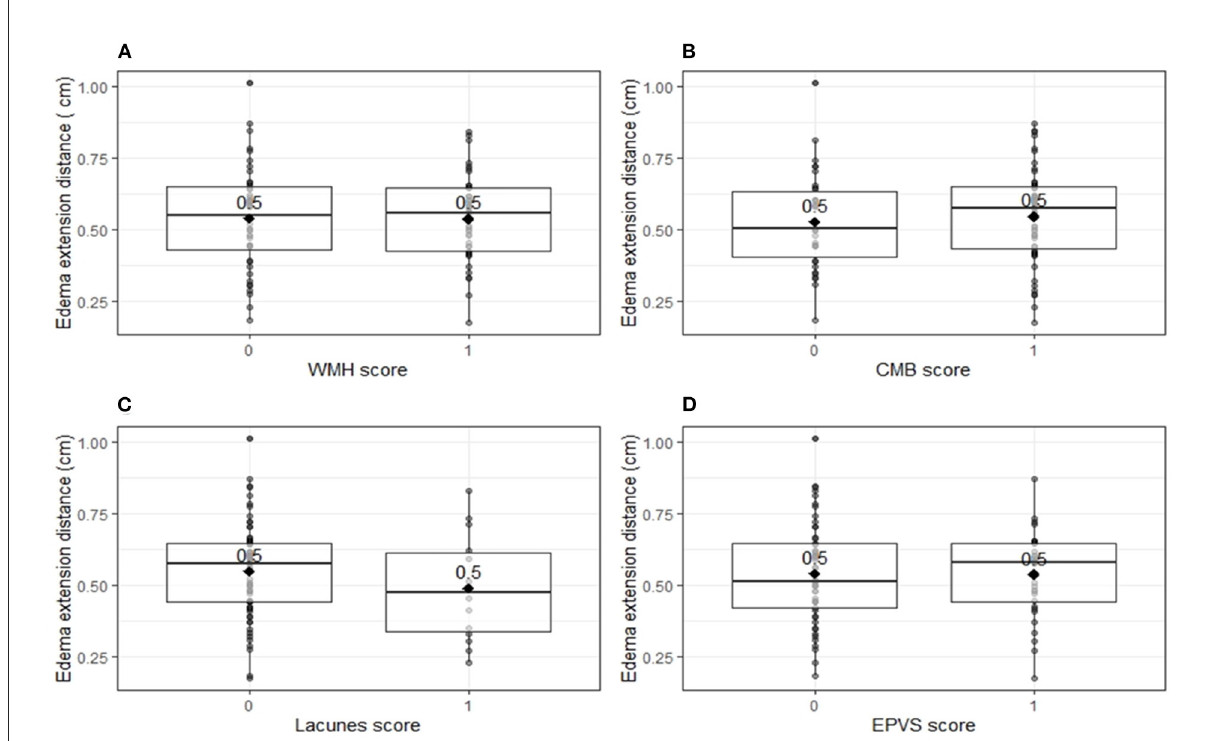
FIGURE2 Edema extension distance per individual markers for cerebral small vessel disease. Boxplots with medians and interquartile ranges. Black diamonds depict mean values. (A) Edema extension distance explored per white matter hyperintensity score ( p = 0.96). One point was assigned when white matter hyperintensities were classified as periventricular Fazekas 3 and/or deep Fazekas 2–3. (B) Edema extension distance explored per cortical microbleeds score ( p = 0.62). One point was assigned when at least one cortical microbleed was present. (C) Edema extension distance explored per lacunes score ( p = 0.28). One point was assigned when at least one lacune was present. (D) Edema extension distance explored per enlarged perivascular spaces score ( p = 0.93). One point was assigned when at least 20 enlarged perivascular spaces were present in the basal ganglia. CMB, cortical microbleeds; EPVS, enlarged perivascular spaces; WMH, white matter